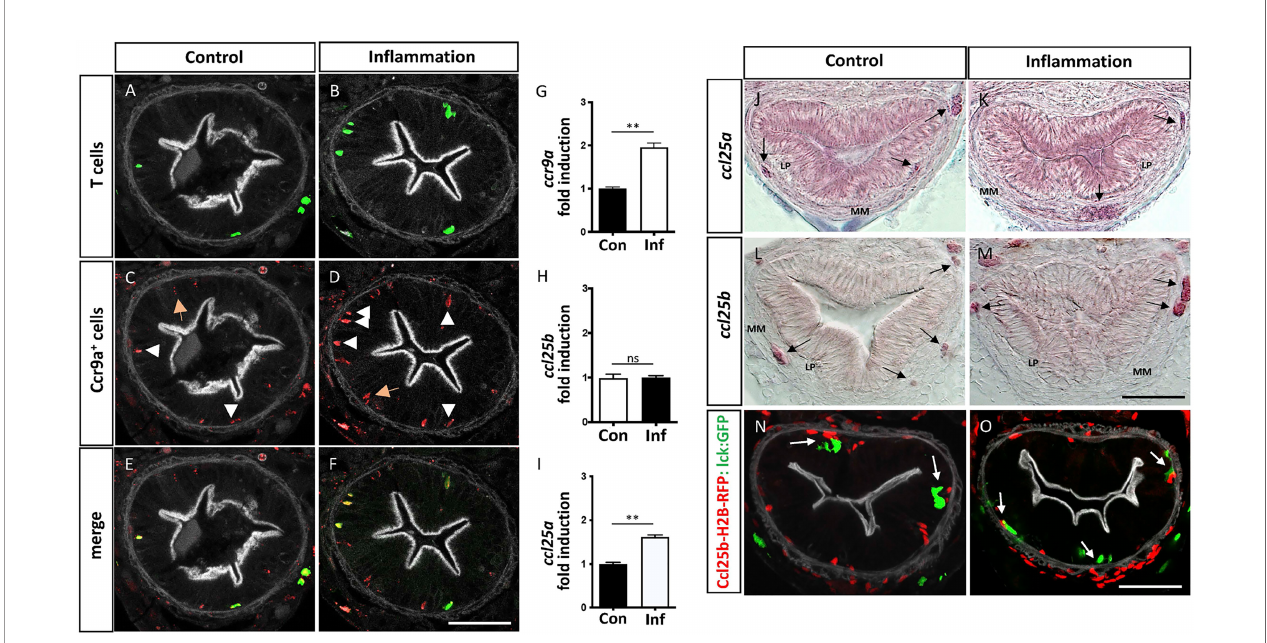
FIGURE 4 | Intestinal T cells are Ccr9a+ and its ligand Ccl25a is expressed by mesenchymal cells. (A – F) Representative images of cryostat sections of the posterior intestine of double transgenic Tg(ccr9a:mCherry;lck:GFP) fi sh showing GFP+ T cells, Ccr9a-mCherry+ cells and their colocalization. Note, that all GFP+ T cells are also Ccr9a-mCherry+ (arrowhead) and a few Ccr9a-mCherry + cells are GFP- (orange arrow). (G – I) Fold of mRNA induction of ccr9a; ccl25a and ccl25b in the in fl ammatory condition respect to the control condition. The data was normalized against elongation factor 1-alpha ( ef1a ) gene. (J – M) Cryostat sections of the posterior intestine of wild type fi sh showing ccl25a and ccl25b mRNA expression pattern in the control and in fl ammatory condition, determined by in situ hybridization with a gene-speci fi c riboprobes White arrows point mesenchymal cells expressing the corresponding mRNA. (N, O) Representative images of cryostat sections of the posterior intestine of double transgenic Tg(ccl25b:H2B-RFP; lck:GFP) fi sh, showing the location of Ccl25b-RFP+ cells (red) and GFP+ T cells (green) in control and in fl ammatory conditions. Statistical analysis was performed with the Mann-Whitney U test. n.s., non-signi fi cant, **p < 0.01. Scale bars 30µm. All assays were performed at least three independent